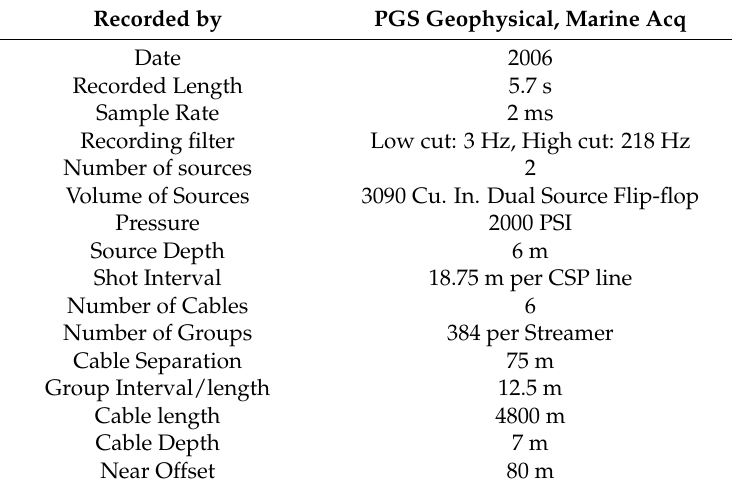
Table 1. Acquisition summary of the study area in Sarawak basin, East